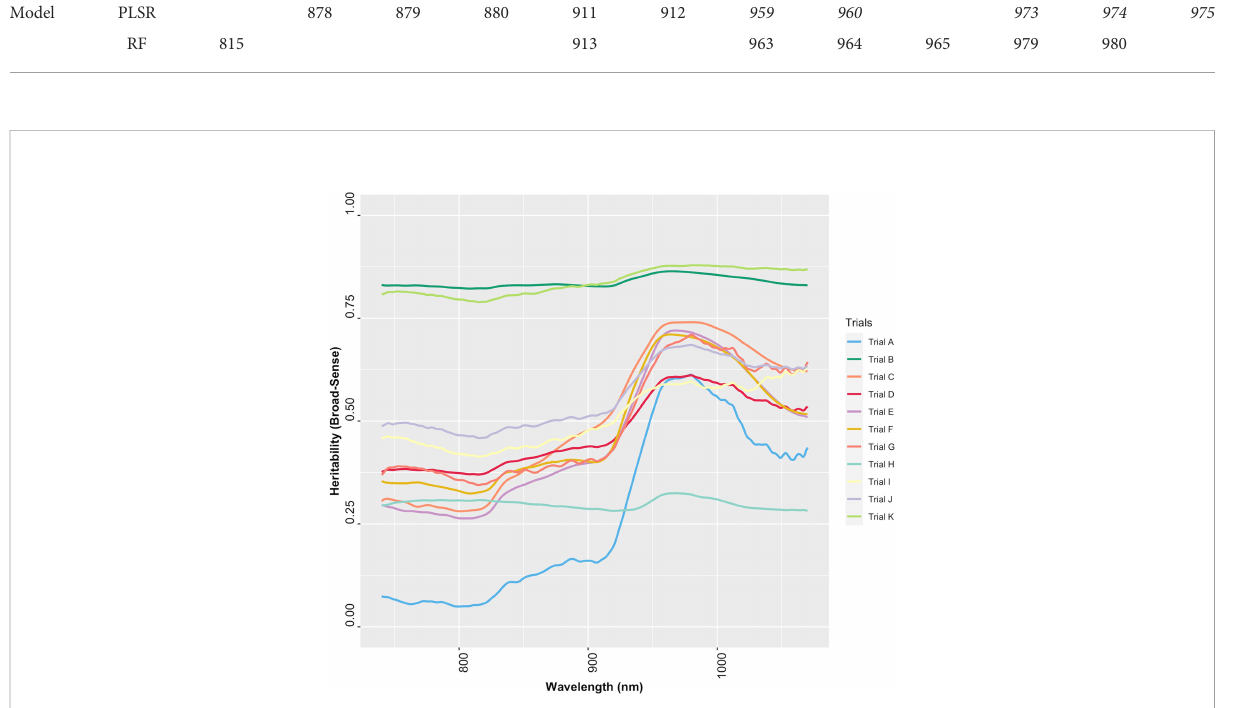
FIGURE 6 Broad-sense heritability of each wavelength of cassava root NIR spectra collected with the SCiO.